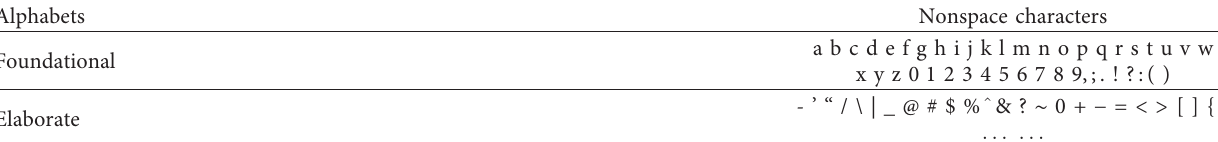
Figure 1: The framework of text classification. Table 1: The nonspace characters of alphabets.